Question: Which visualization type does this figure use?
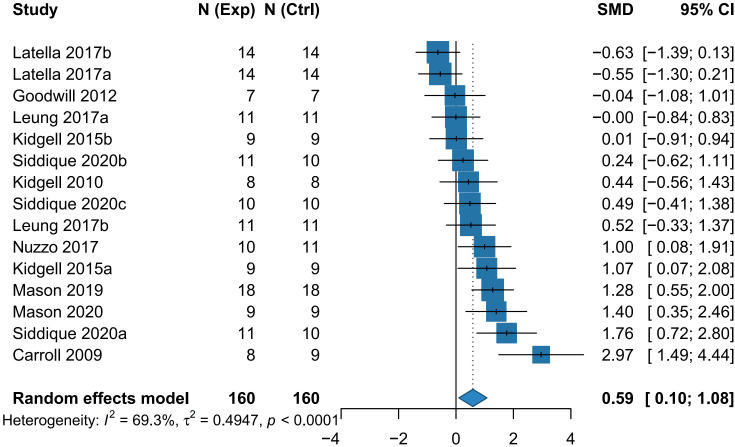
Answer: forest